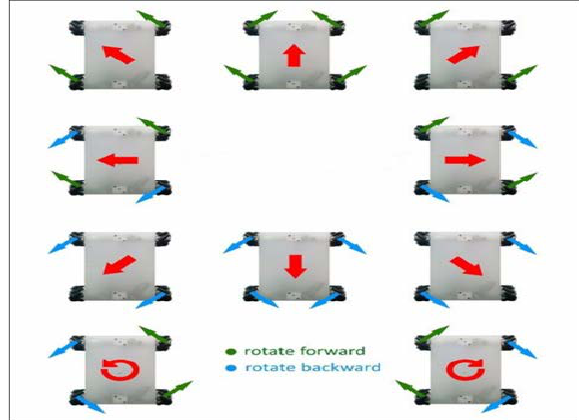
Figure 4. Achievable motions by the wheelchair [18].